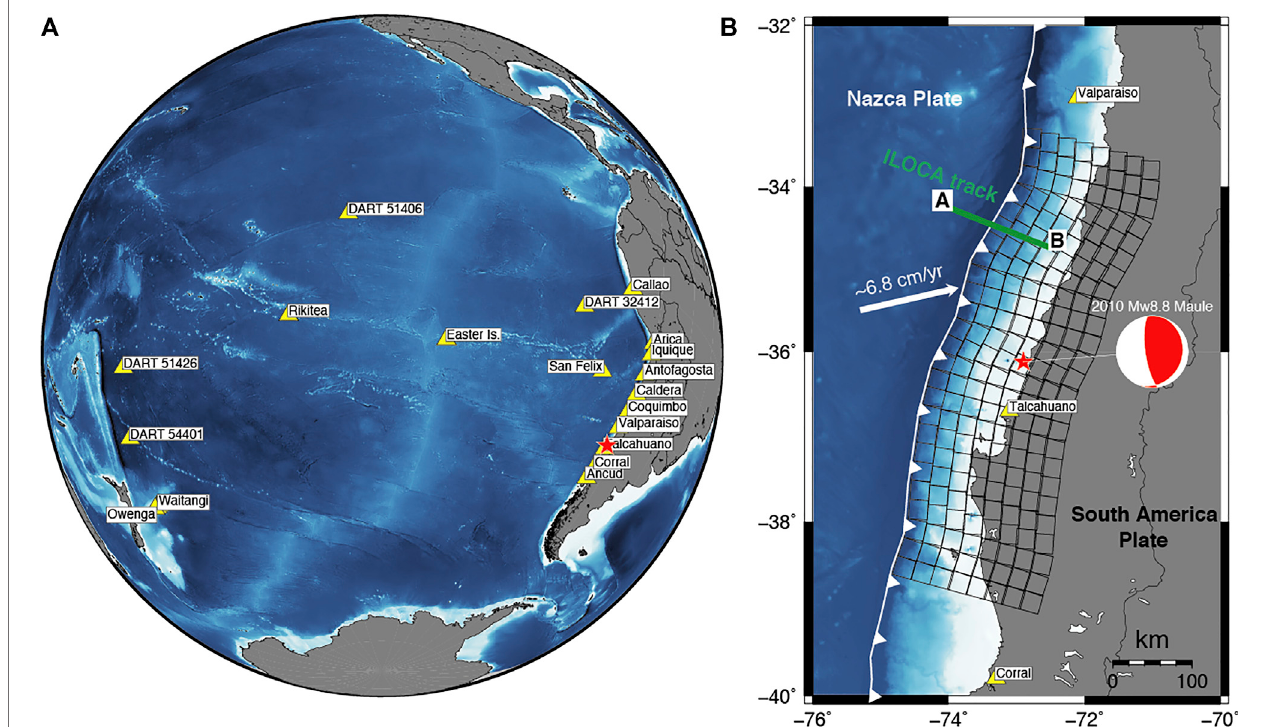
FIGURE 1 | (A) Tsunami sensors (yellow triangles); (B) fault geometry (black squares), epicenter (red star) and average faulting geometry (red and white focal mechanism) of the 2010 Maule earthquake. A – B segment is the ILOCA track (green line).